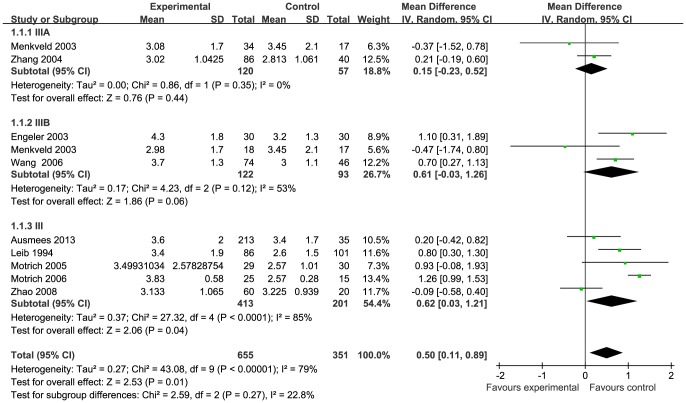
Forest plot showing the meta-analysis outcomes of the effect of CP/CPPS on semen volume.